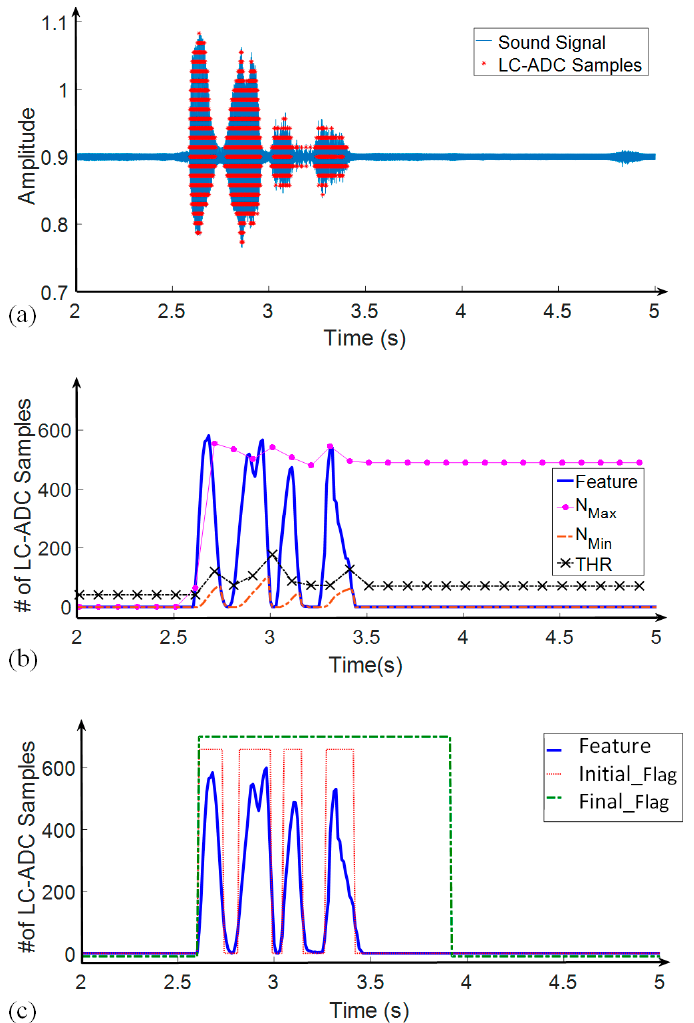
Figure 10. Basic operation of the proposed VAD algorithm. ( a ) A small part of the audio input signal, LC-ADC output samples. ( b ) Feature, N Max , N Min , THR signals. ( c ) Feature, Initial_Flag, Final_Flag signals.